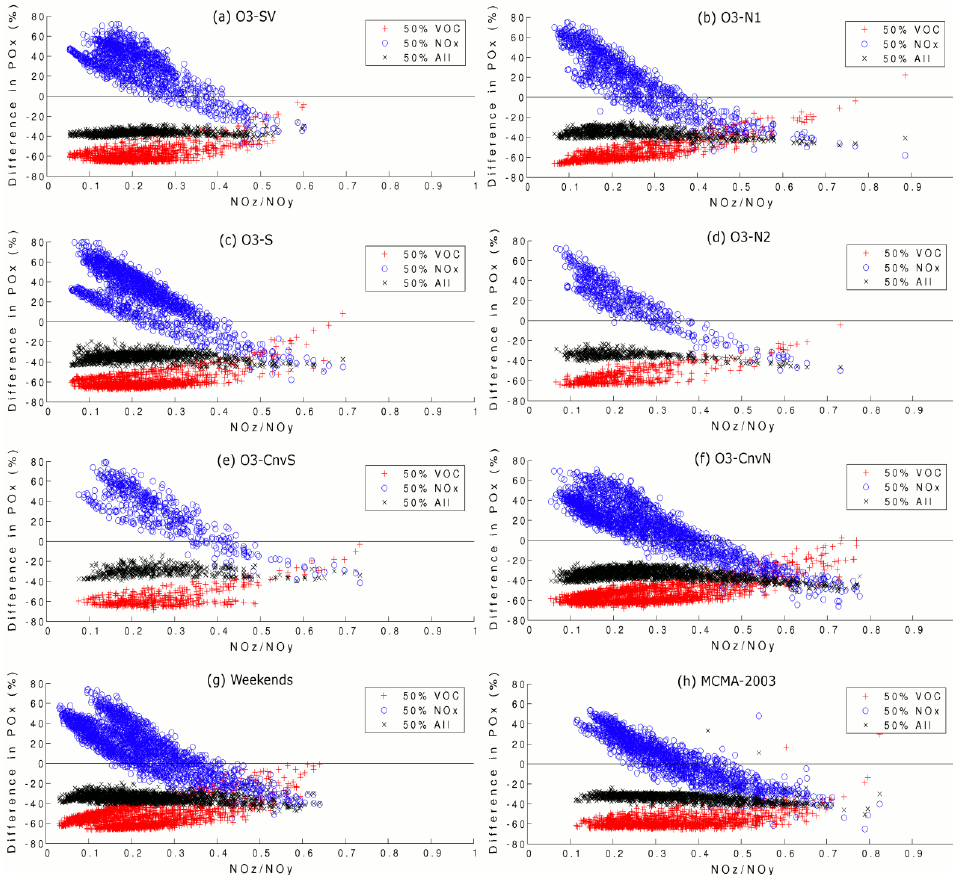
Fig. 13. Percentage change of P(O x ) as a function of chemical aging in the urban area at 12-17 LT during (a)-(g) MCMA-2006 and (h) MCMA-2003. (a)-(g) were sampled on weekdays during different meteorological episodes, (g) was sampled on weekends, and (h) was sampled during a O 3 -South episode. Young air mass on the left (low NO z /NO y values) and aged air mass on the right (high NO z /NO y values).